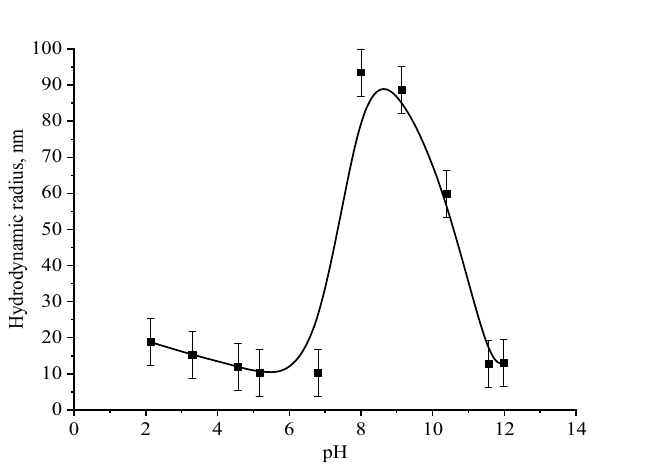
Figure 16. The dependence of average hydrodynamic radius of the positive Se NPs sol on pH after 1 week of